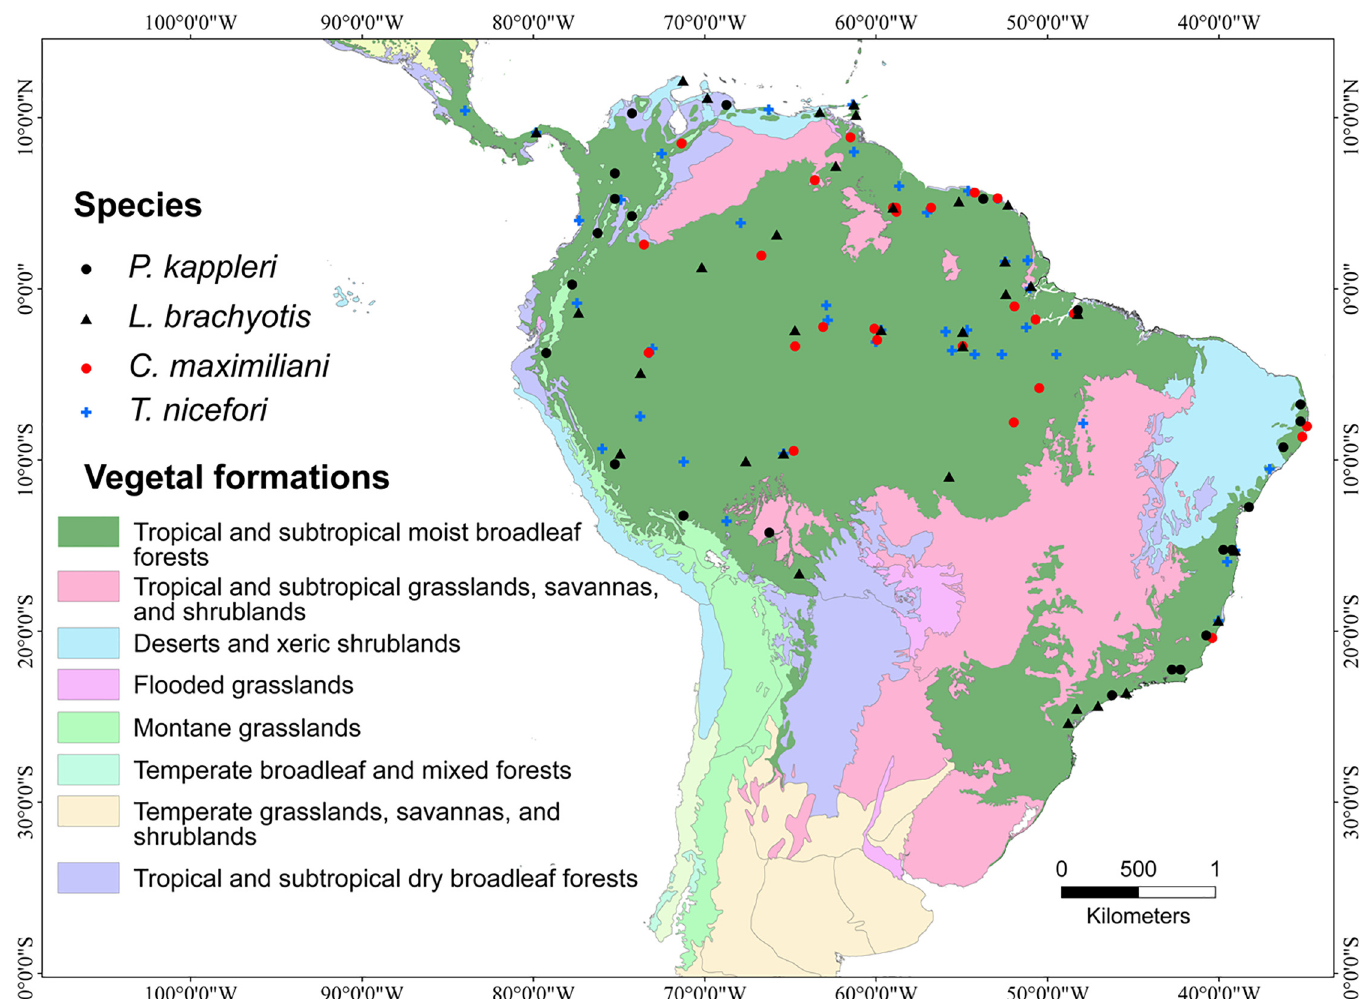
Fig 1. Distribution of South American biomes (according to the World Wide Fund for Nature) showing the point locality records of all four species used to build the ensemble niche models presented here.